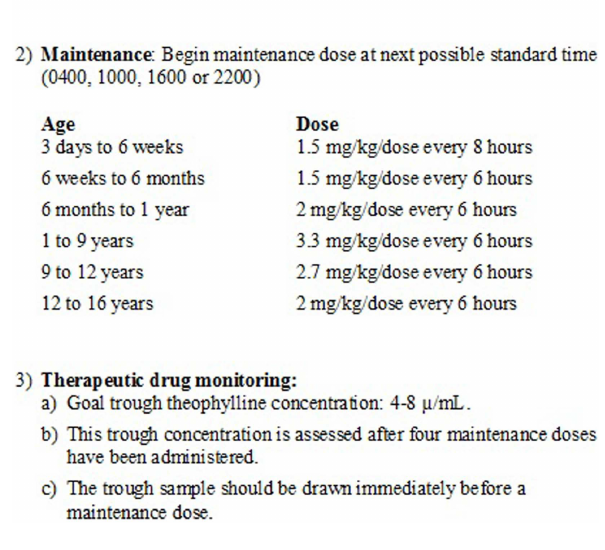
FIGURE 1 |Aminophylline dosing guidelines .The figure depicts the standard intermittent dosing regimen used at the study center.This dosing regimen is based on institution-specific clinical experience.The goal trough theophylline concentration is 4–8 µ g/mL.This trough concentration is assessed after four maintenance doses have been